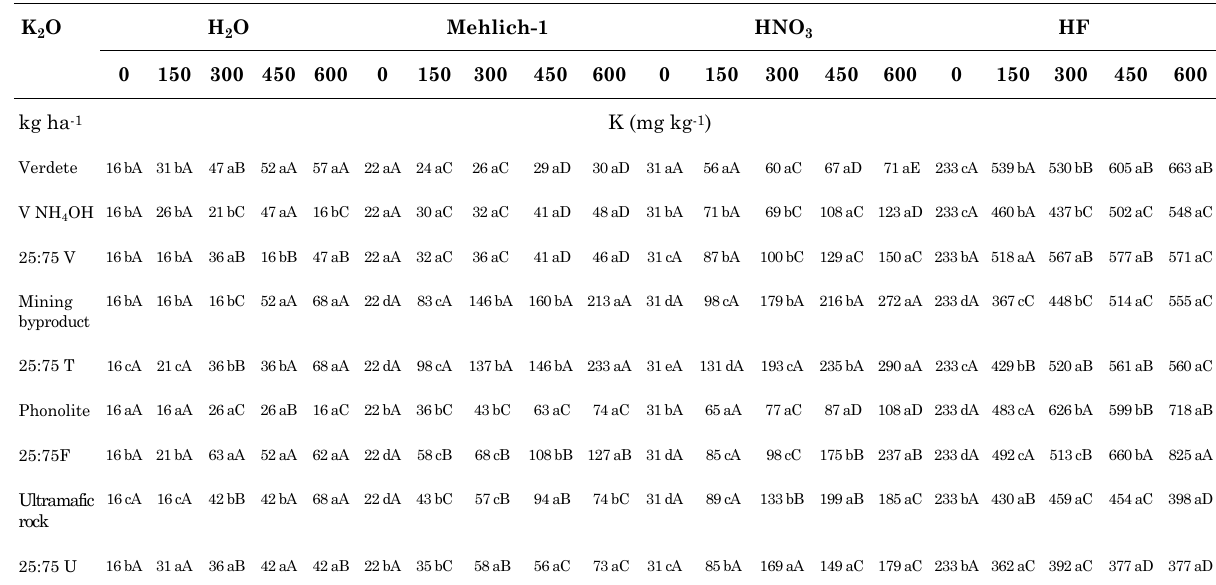
Table 1. Potassium fractionation in soil after a 45-day incubation, as affected by the different rates and treatments